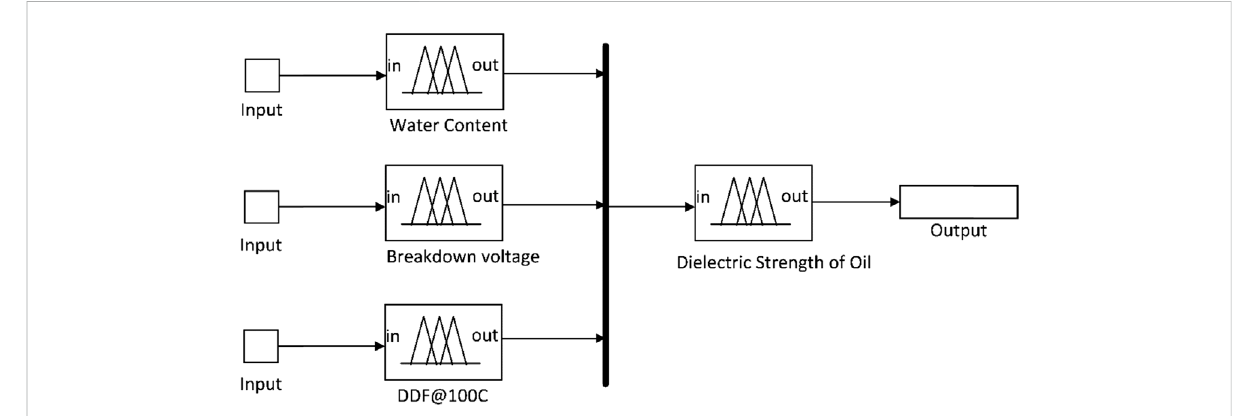
FIGURE 1 Fuzzy sublogic based on dielectric strength of oil.